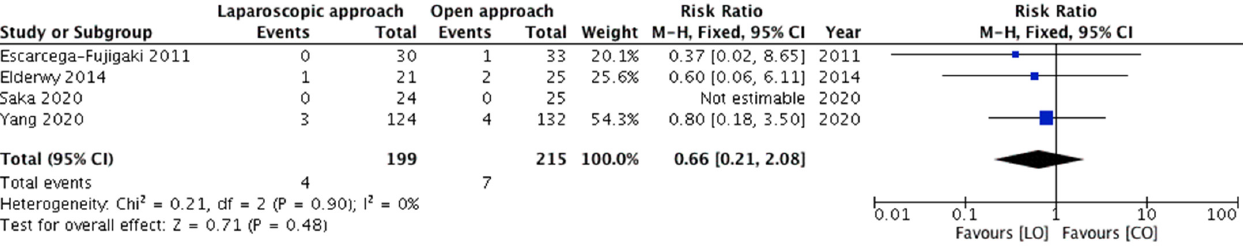
Figure 3. Forest plot comparison between the two treatment groups for the incidence of early postoperative complications.